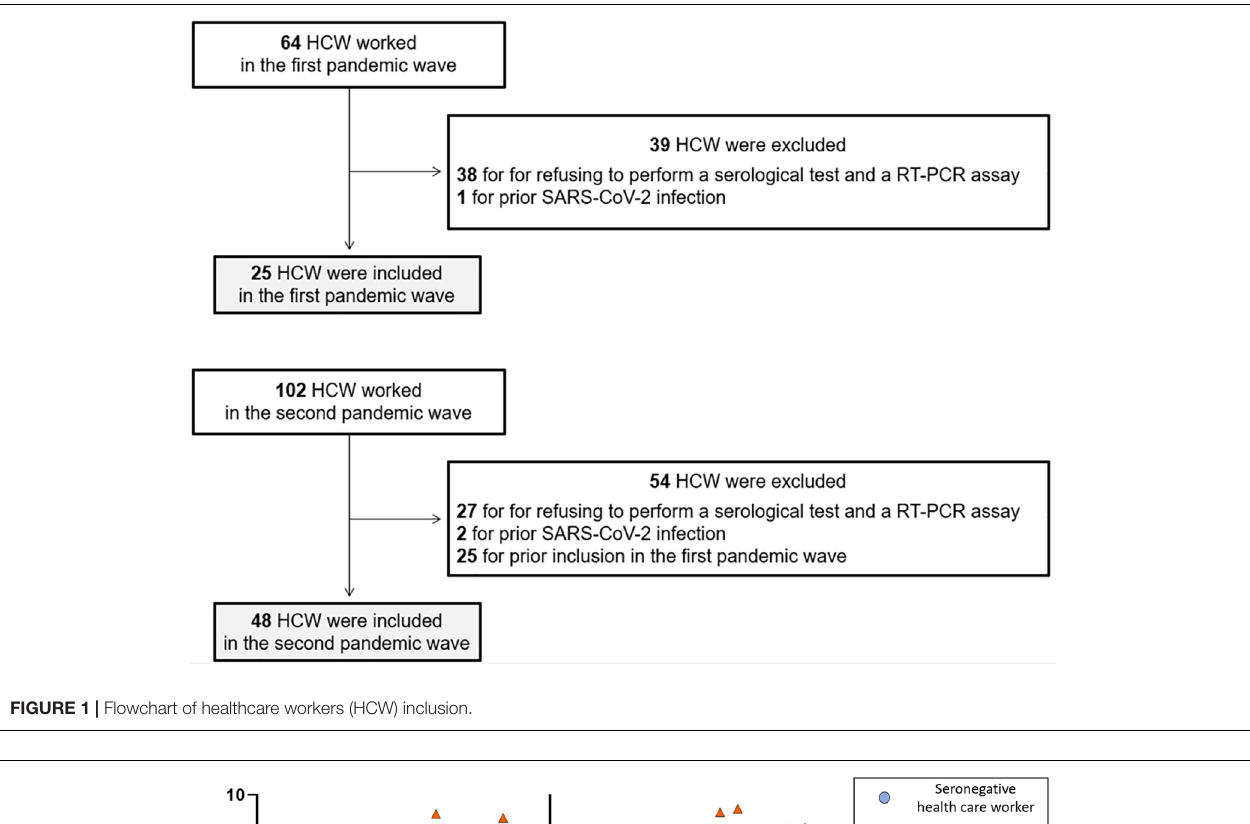
FIGURE 1 | Flowchart of healthcare workers (HCW) inclusion.